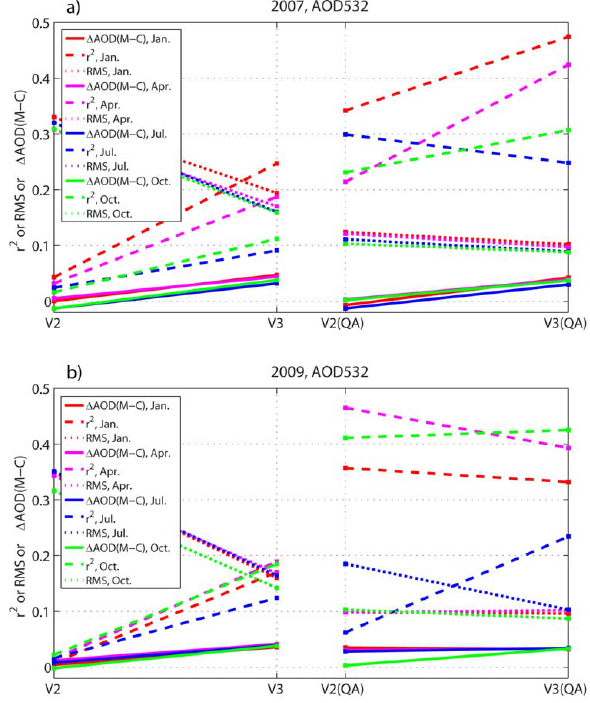
Fig. 4. (a) Left - Comparison of agreement between MODIS AOD and CALIOP V2 and V3 AOD, respectively, in terms of difference in mean AOD, square of the linear correlation coefficient, and rms difference, for four months in 2007. Right – same as left, but for data after application of comparison #3 in Table 1. (b) same as (a) , but for four months in